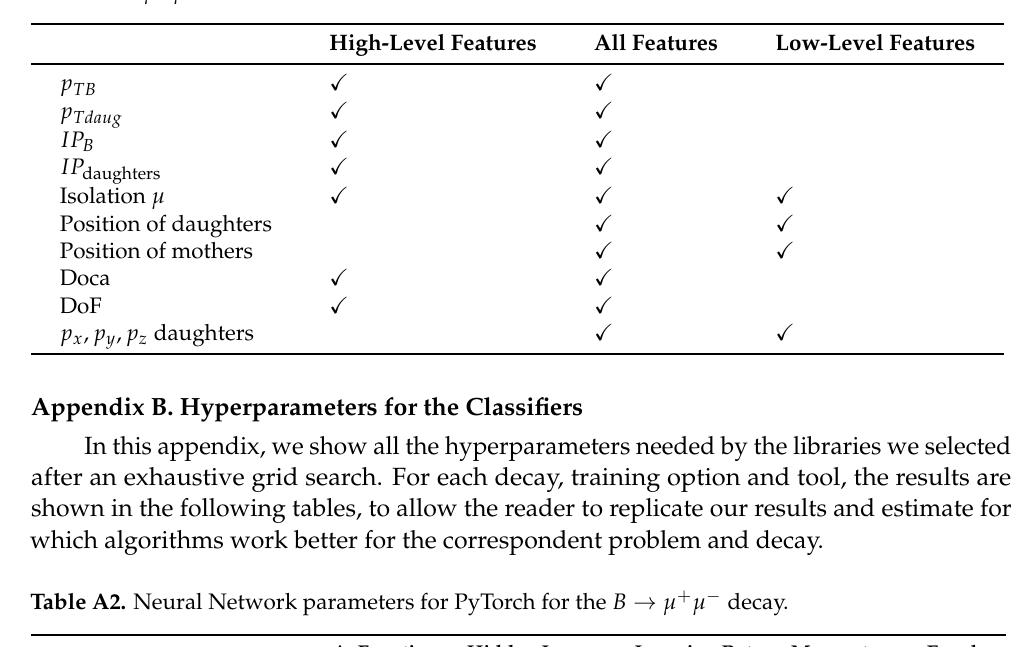
Table A2. Neural Network parameters for PyTorch for the B